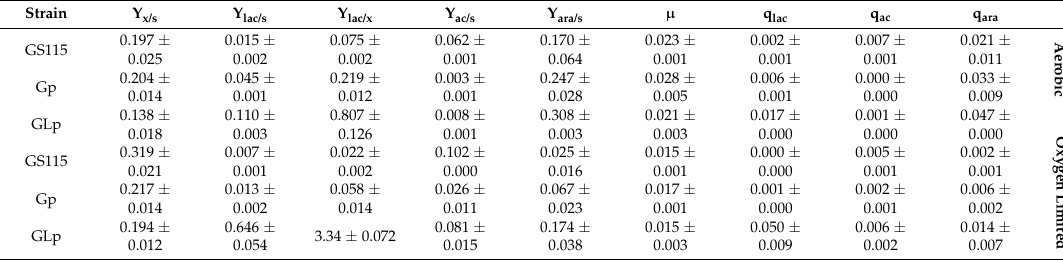
Table 3. Kinetic parameters during fermentation experiments at aerobic and oxygen limited phases. Y: yield, s: substrate, x: biomass, lac: lactate, ac: acetate, ara: arabitol, Y: g/g, q: g/g/h, r: g/L/h.